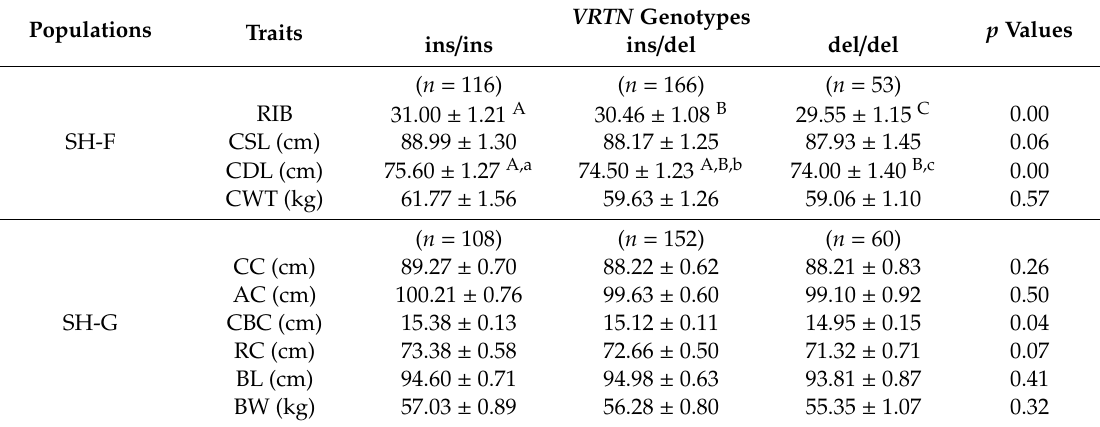
Table 5. Association analyses of the polymorphism of the VRTN gene g.20311_20312ins291 with RIB and carcass traits in Suhuai fattening pigs and body size / body weight traits in Suhuai gilts. Populations